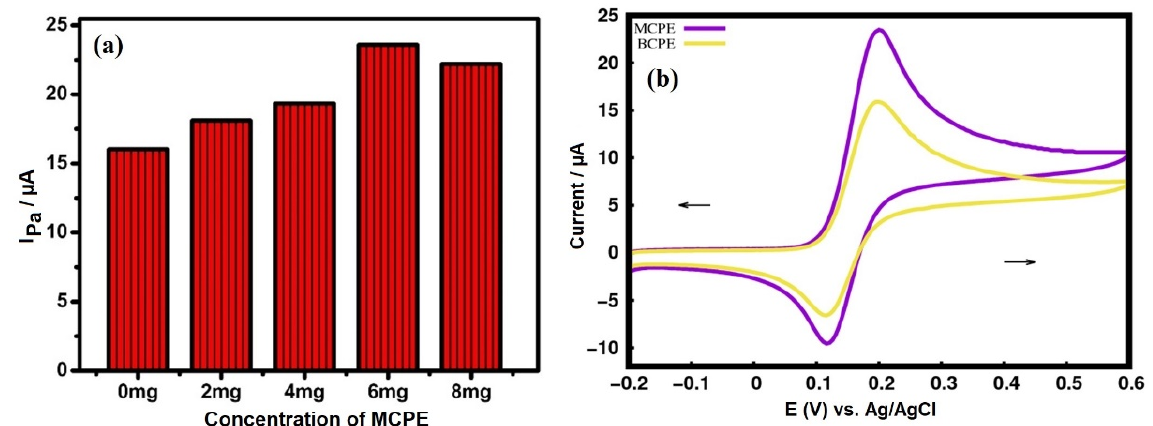
Figure 8. ( a ) A graph of various concentrations of CuO NPs along with their respective anodic peak currents. ( b ) The cyclic voltammogram of BCPE and 6 mg concentration of the CMCPE at 2 mM DA concentration. The cyclic voltammogram of 0.1 mM DA at BCPE and CuO-MCPE is shown